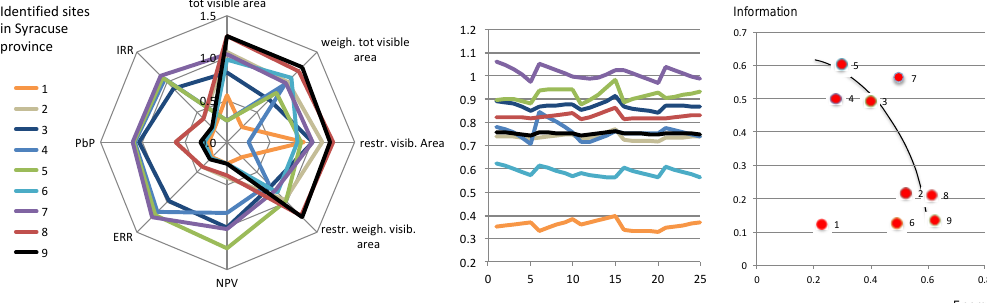
Figure 11. Assessment and comparison of the various plants considered; trade-off between Energy and Information (The criteria in terms of energy are NPV—Net present value, ERR—External rate of return, PbP—Pay Back Period, IRR—Internal Rate of Return; The criteria in terms of information are tot. visible —total visible area; weigh. visible area—weighted visible area; restr. visible area—restricted visible area; weigh. restr. visible area—weighted restricted visible area).